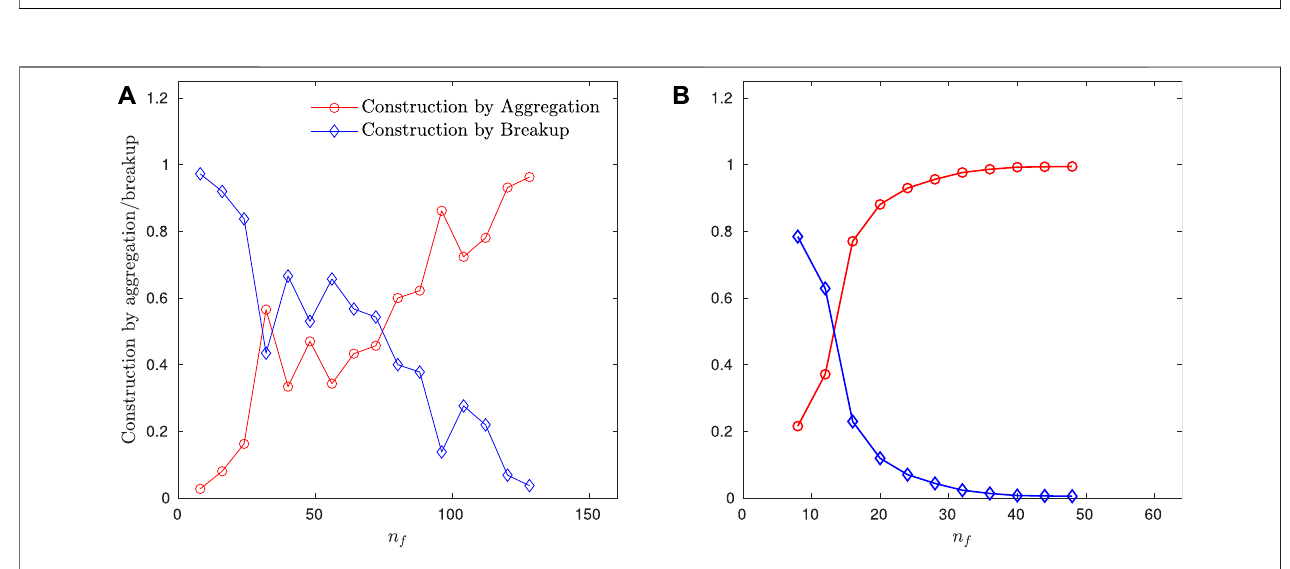
FIGURE 11 | Relative importance of the two construction mechanisms for fl ocs of size n . (A) Case P 2 S 1 and (B) P 2 S 2 .